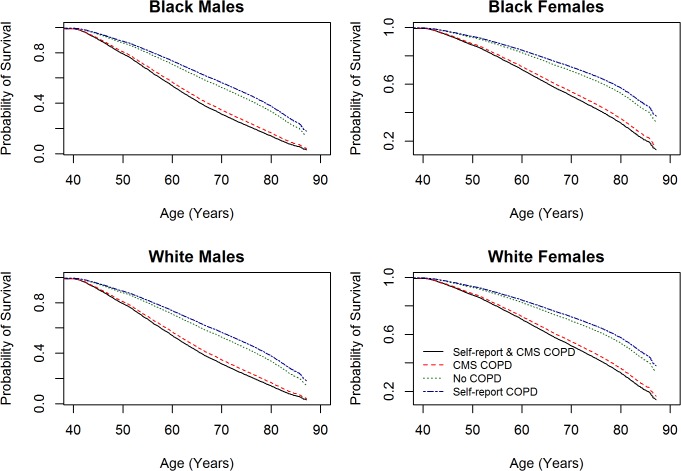
Predicted survival probabilities from Cox proportional hazard models of all-cause mortality by COPD status for each of the four race-sex groups.